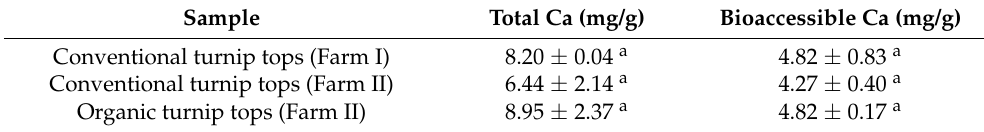
Table 2. Ca total and bioaccessible (mg/g dry weight) in turnip greens (mean ± standard deviation). Sample Total Ca (mg/g) Conventional turnip greens (Farm I) Organic turnip greens (Farm II)